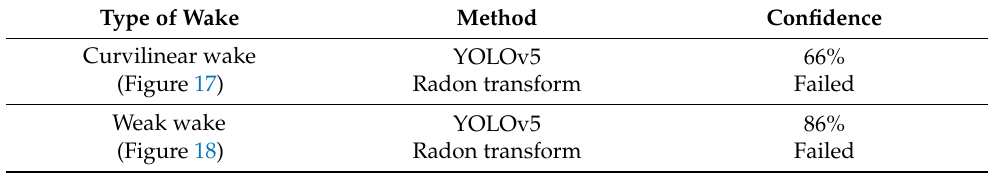
Figure 18. The comparison diagram of the result of weak wake detection: ( a ) wakes in a strong noise background; ( b ) result of YOLOv5 detection; ( c ) result in the Radon transform domain; ( d ) inversion result of the local Radon transform based on several most obvious peaks in ( c ). Table 6. Comparison of detection effects between YOLOv5 and the Radon transform. Type of